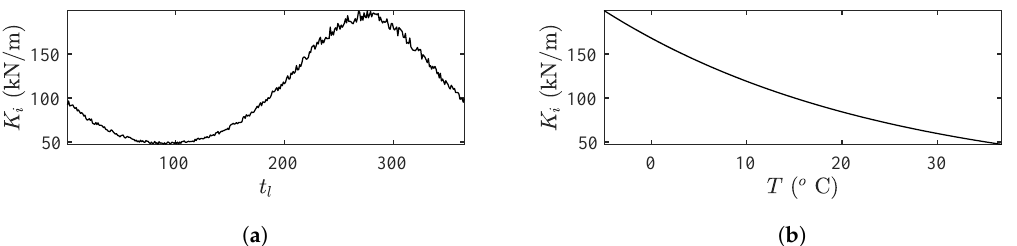
Figure 4. Spring-mass-damper: structural stiffness for the temperature realization of Figure 3. ( a ) K i vs. t l . ( b ) K i vs. T